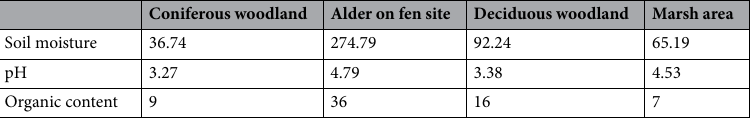
Table 5. Means of each soil factor per biotope.